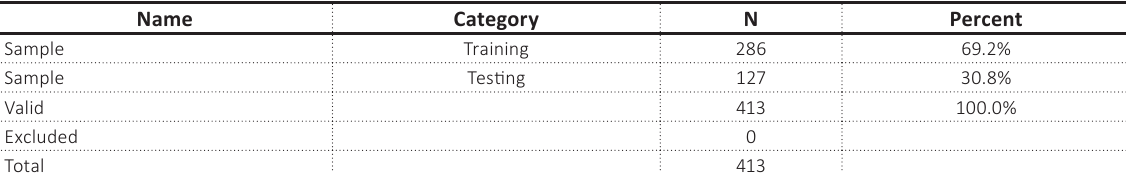
Table 2. Case processing